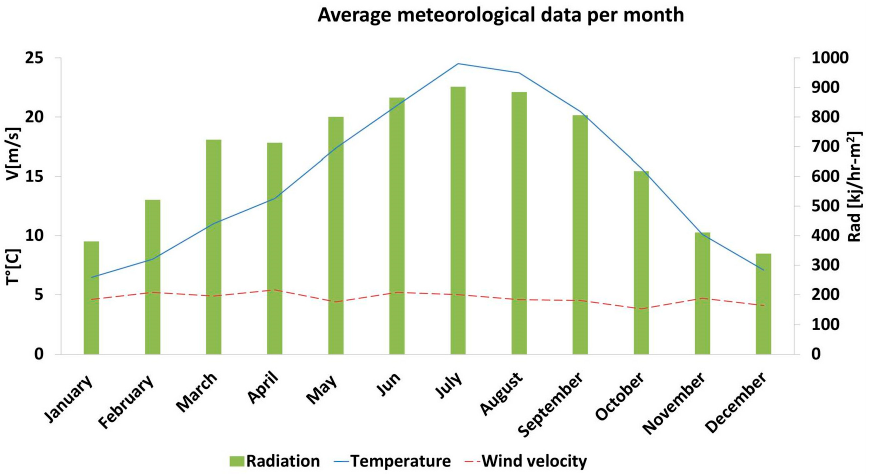
Figure 4. Zaragoza meteorological data.